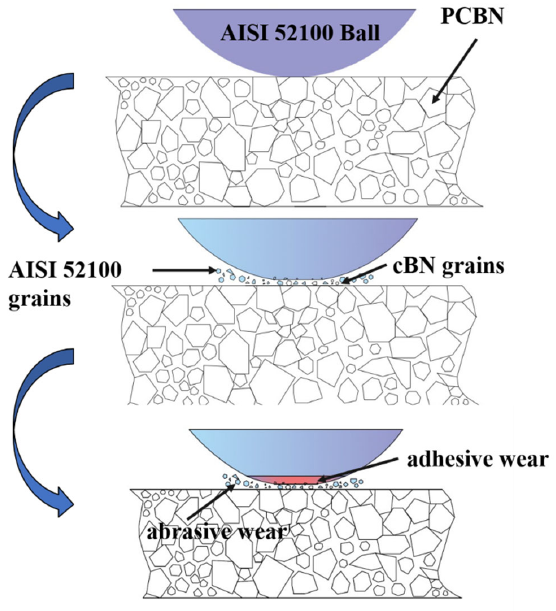
Figure 5. Wear mechanisms of PcBN and AISI 52100.